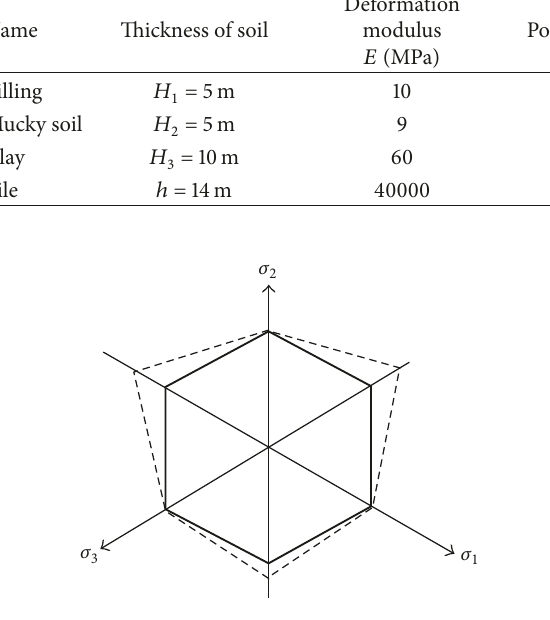
Figure 1: Mohr–Coulomb yield